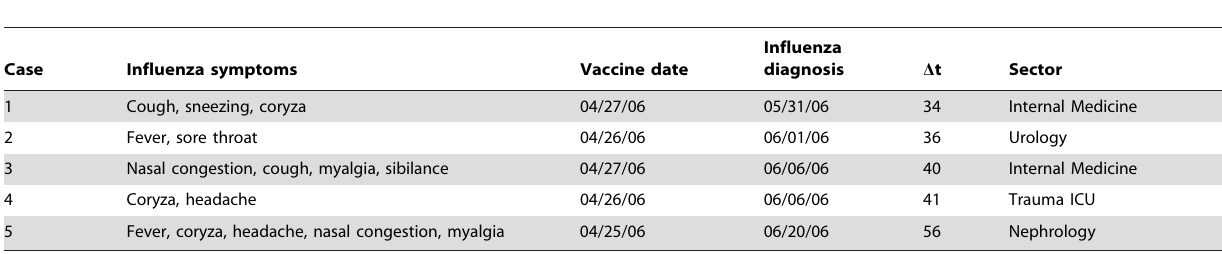
Table 3. Time to influenza diagnosis according to vaccination date of HCWs and respective workplaces.